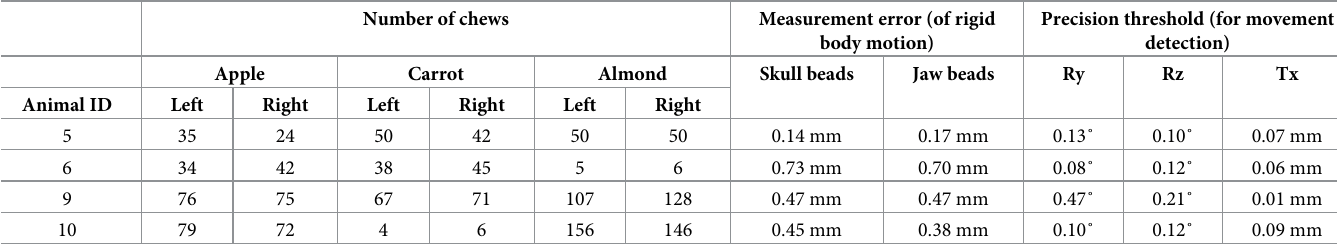
Table 1. Sample sizes, measurement errors and precision thresholds for each animal.